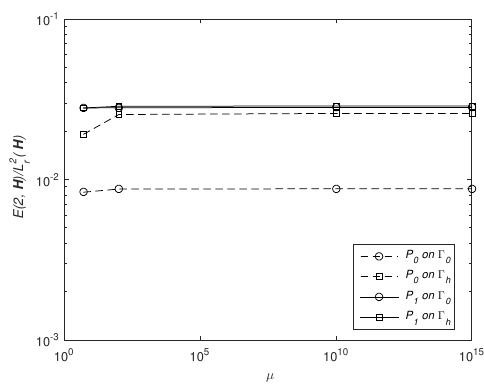
Figure 2. The relative error of the approximate boundary field versus the relative permeability.